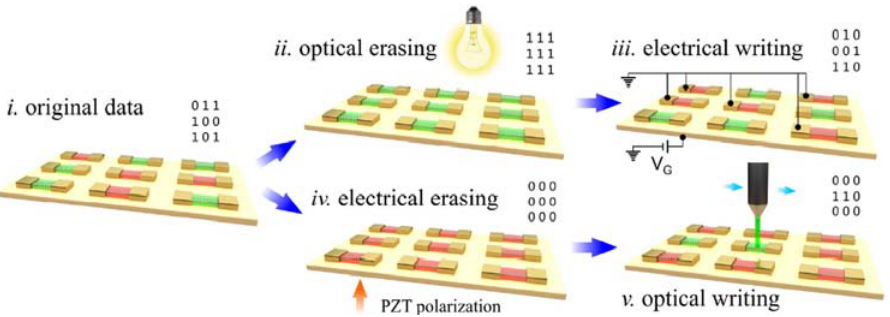
Figure 23. “Optical erase-electrical write” and “electrical erase-optical write” operation of MoS 2 -PZT memories. Reproduced with permission from [250], American Chemical Society, 2015.